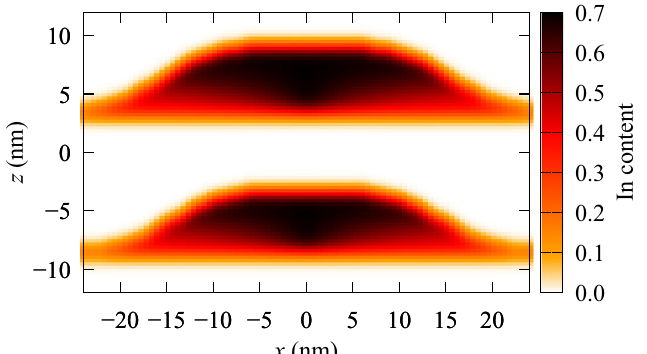
Figure 1. In x Ga 1 x As distribution in the QDM −